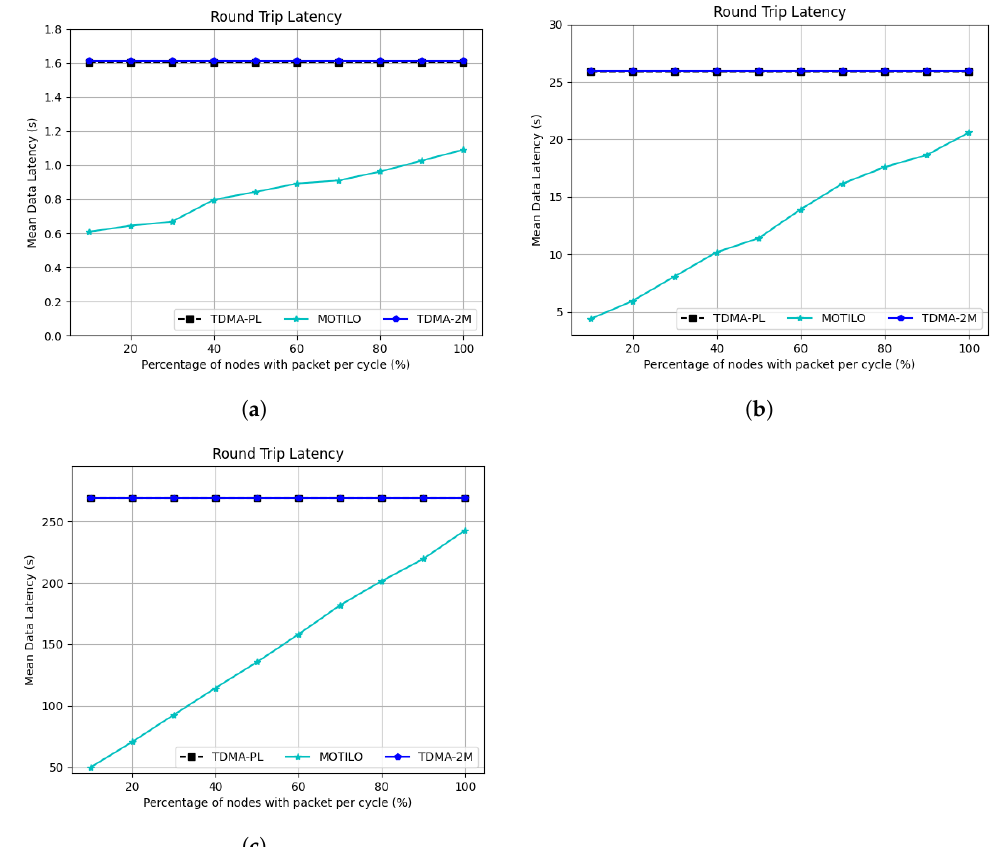
Figure 5. Mean data latency (s) under variable traffic load for LoRa networks with ( a ) 9, ( b ) 99 and ( c ) 999